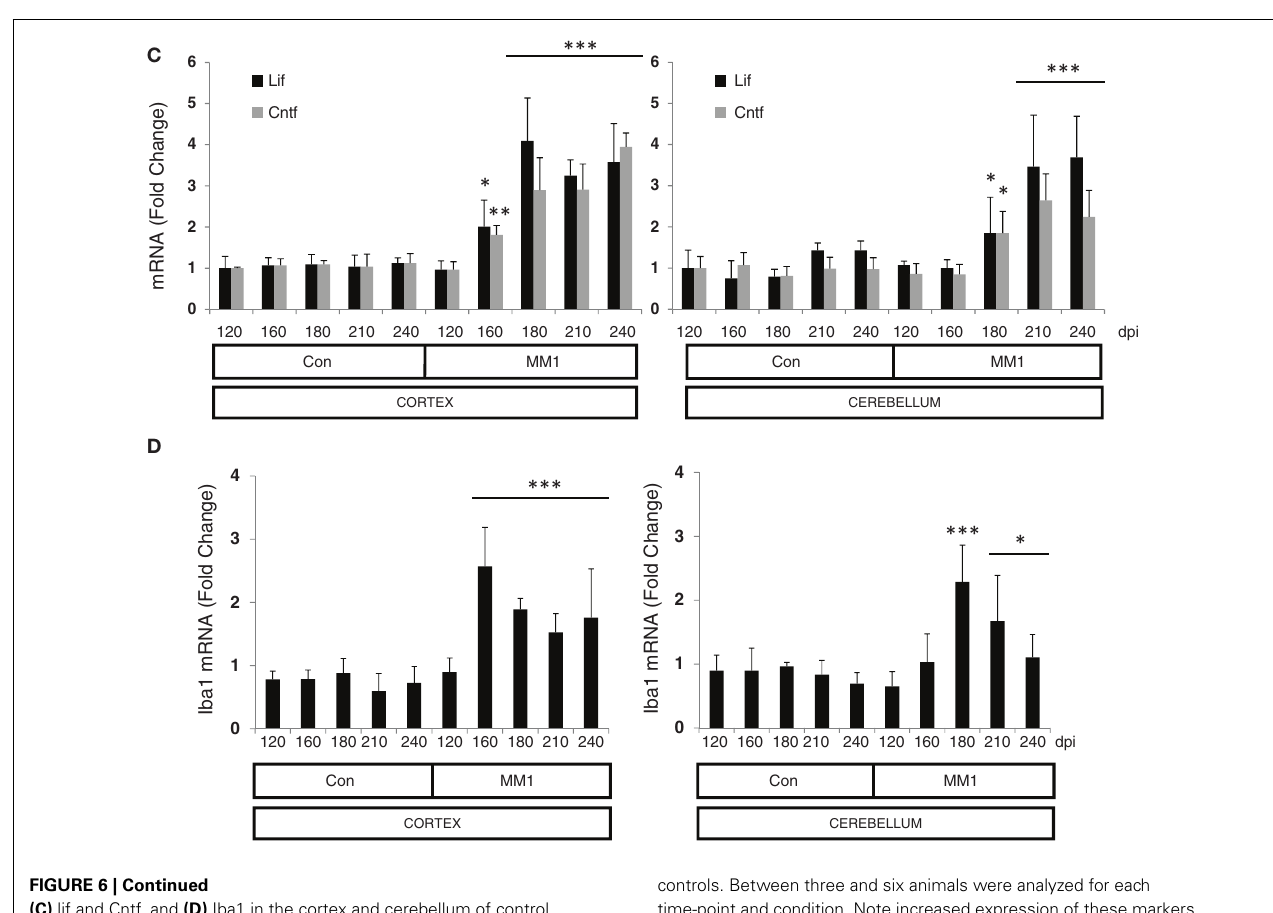
FIGURE 6 | Continued (C) lif and Cntf, and (D) Iba1 in the cortex and cerebellum of control and MM1-inoculated mice at different dpi. 10 − 1 and 10 − 2 inoculum dilutions were performed in animals sacrificed at 210 and 240dpi, respectively.Values are normalized using Xpnpep1 as internal